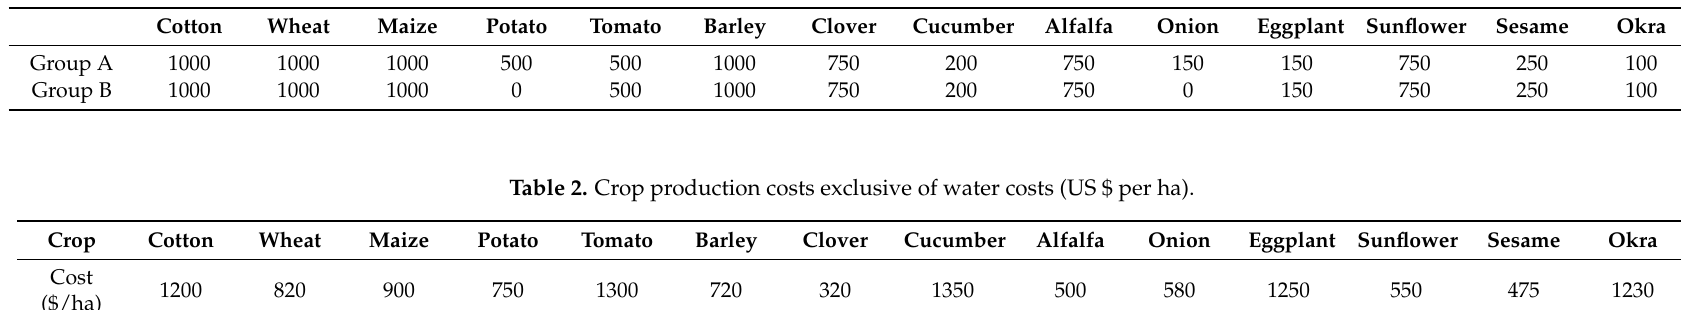
Table 1. Maximum allowed areas (ha) to be cultivated by certain types of crops irrigated using two reclaimed water (RW) qualities.